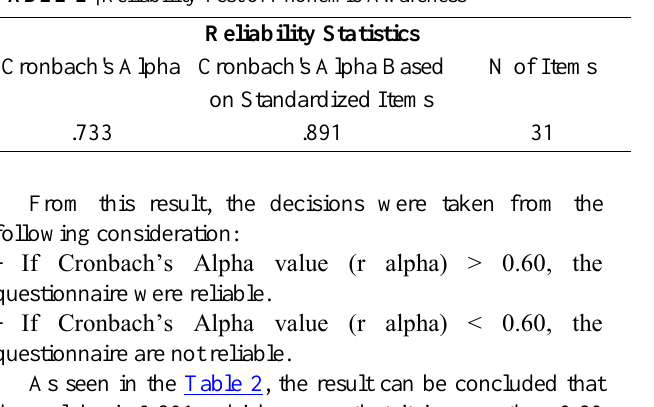
TABLE 2 | Reliability Test of Phonemic Awareness